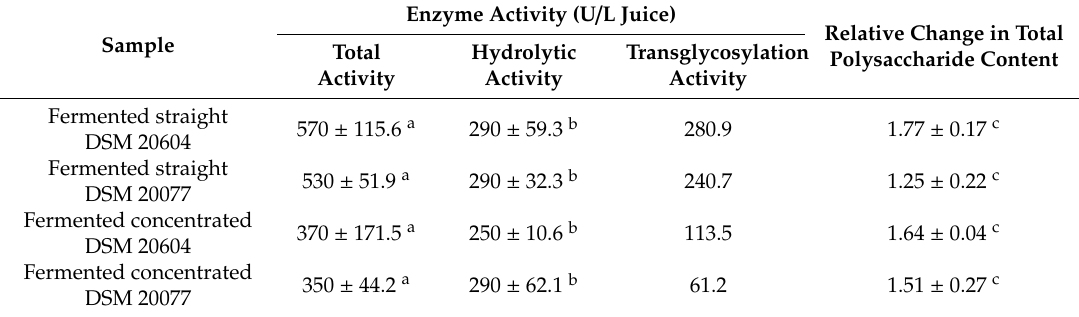
Table 1. The activity of fructosyltransferase enzymes and relative changes in total polysaccharide contents (the ratio of fermented to non-fermented samples) in carrot juice samples fermented by L. gasseri DSM 20604 and DSM20077. Similar letters in the prefixes within column indicate no significant di ff erence ( p > 0.05). The estimated crude polysaccharide contents of the straight and concentrated carrot juices were 11.7 mg / mL and 24.7 mg / mL,